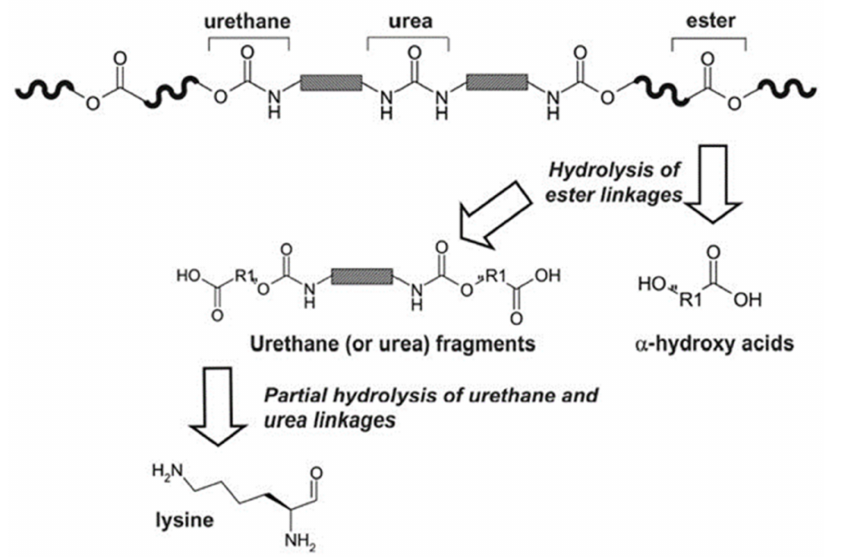
Figure 12. Postulate mechanism of PU biodegradation. Reprinted from [23] with permission from